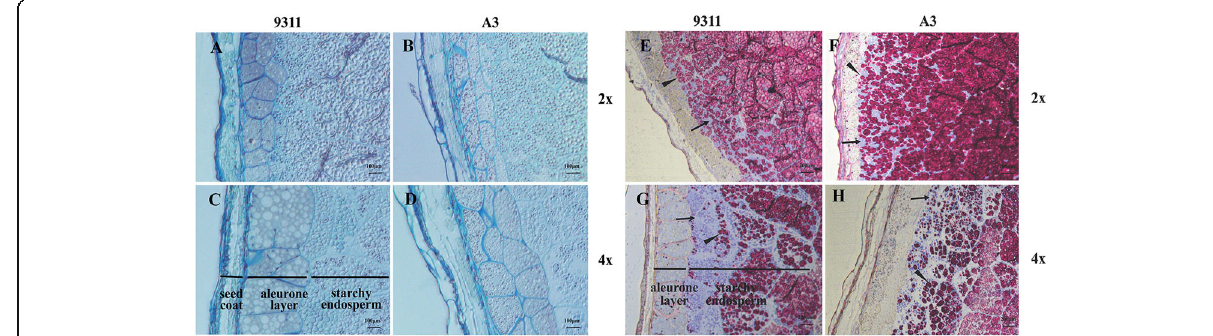
Fig. 6 Variations in endosperm structural characterization in rice seeds with various ploidy levels. Semi-thin sections of the dehusked immature seeds of 9311 and A3 (harvested in 2018) at 17 DAF stained with methylene blue, ( A – D ) PAS, and CBB ( E – H ). Scale bar: 100 μ m ( A – D ) and 200 μ m ( E – H ). Seed coat, aleurone layer, and starchy endosperm are represented by black horizontal lines. Blue granules are indicated by black arrowheads, which represent plant proteins. Red granules are indicated by black triangles, which represent plant